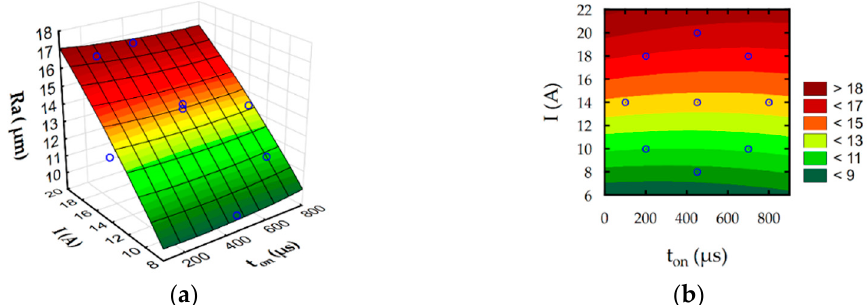
Figure 12. Estimated for roughness Ra: ( a ) response surface and ( b ) contour plot.